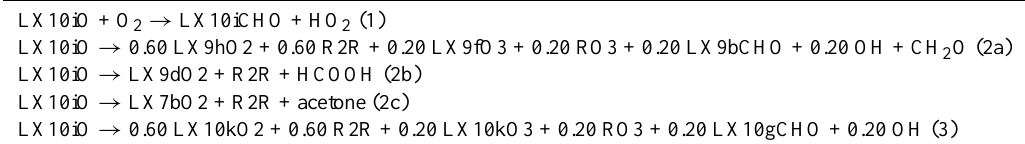
Table 1. Illustration of generic alkoxy radical reactions included in BOREAM. R2R and RO3 denote peroxy radical counters (Capouet et al., 2004). The rates of these reactions are detailed in the